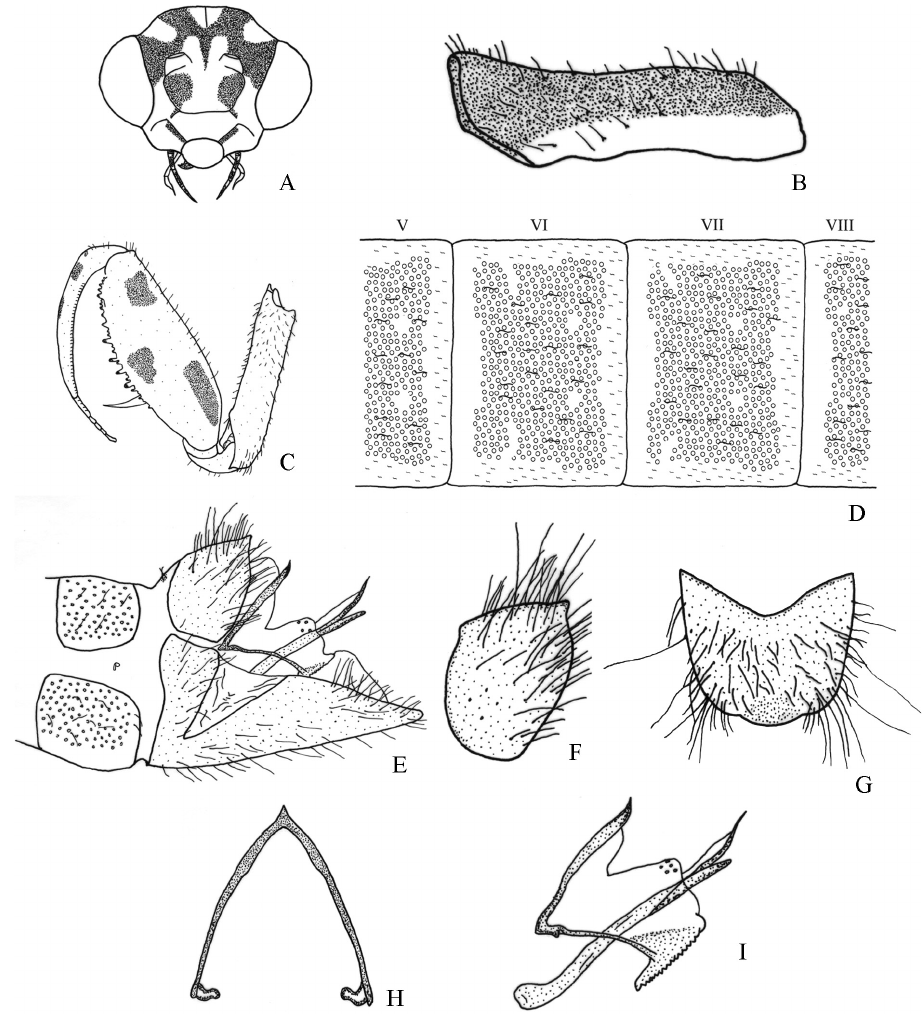
Figure 6. Structures of the male of Nolima costaricensis sp. nov. A head, frontal B prothorax, lateral C left foreleg, lateral D abdominal terga V–VIII, dorsal E external terminalia, lateral F left ectoproct, lateral G ectoprocts, dorsal H gonarcus, dorsal I internal terminalia,